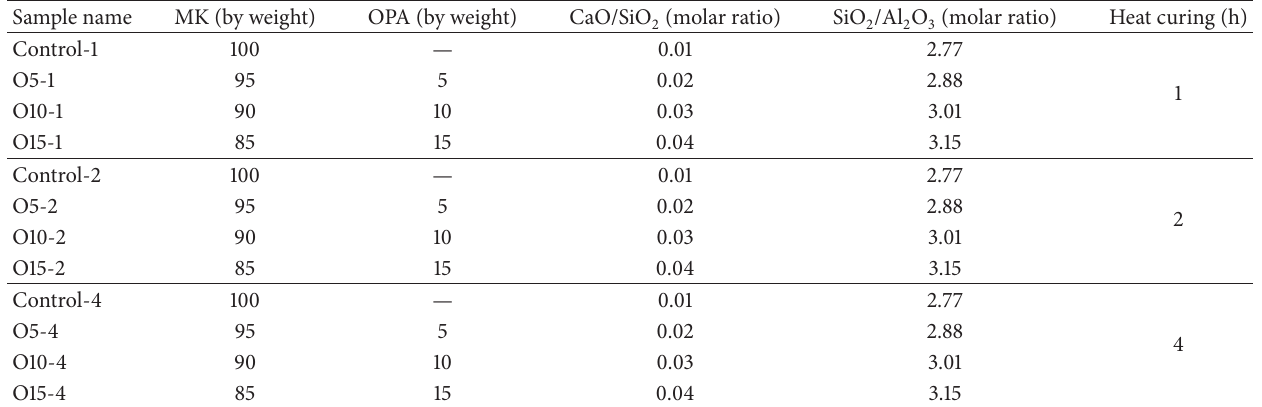
Table 2: Mix proportions of geopolymer